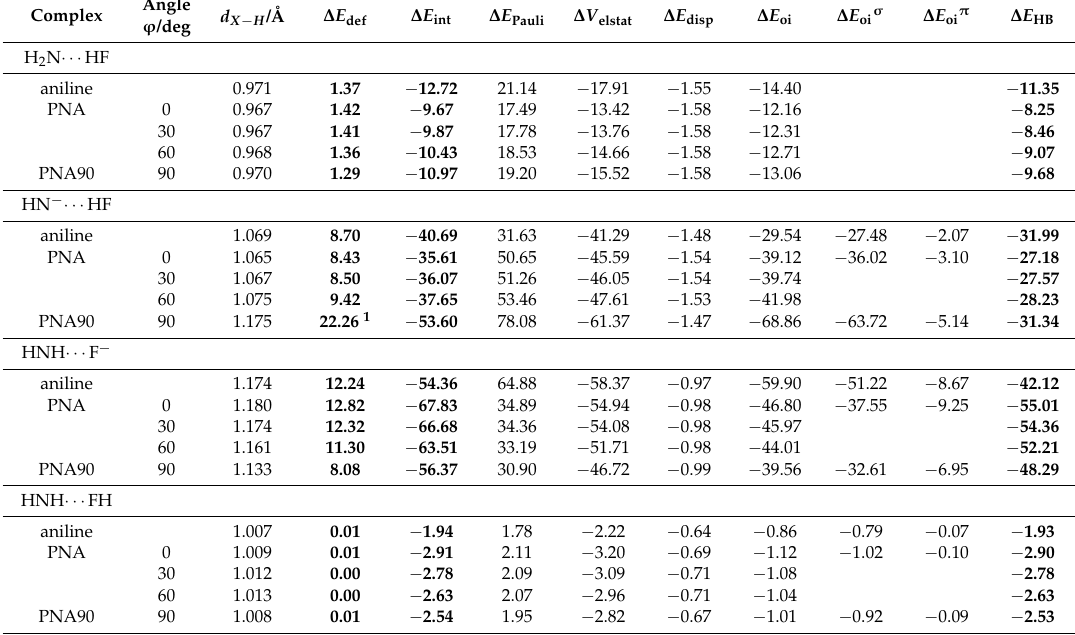
Table 2. Energy decomposition analysis ( ∆ E in kcal/mol) for H-bonded complexes of aniline and p -nitroaniline (X = F for N···H interactions, X = N for H···F ones). For HNH···F − interactions d N···F = 2.65 Å (no proton transfer).